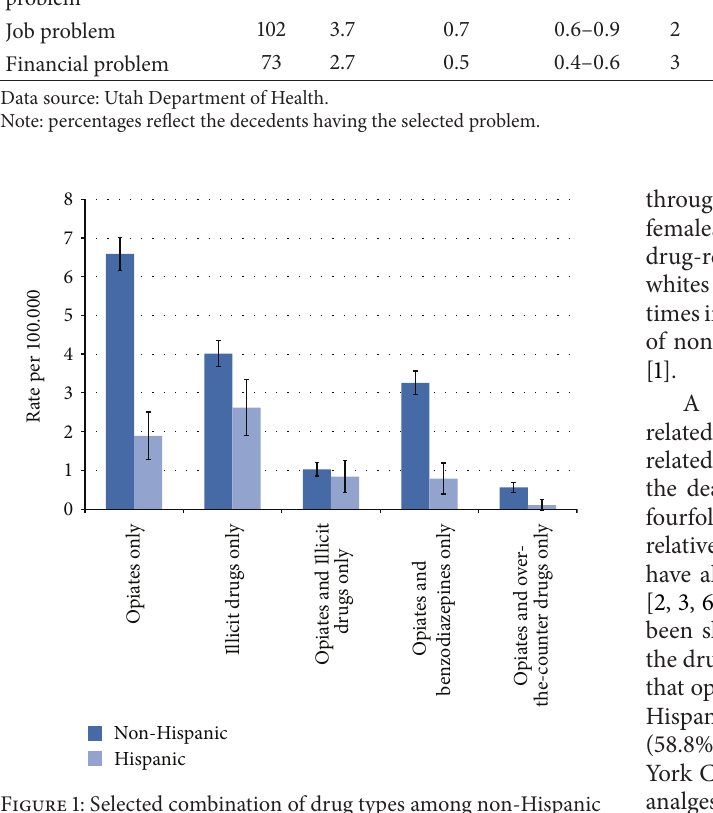
Figure 1: Selected combination of drug types among non-Hispanic and Hispanic decedents in Utah,